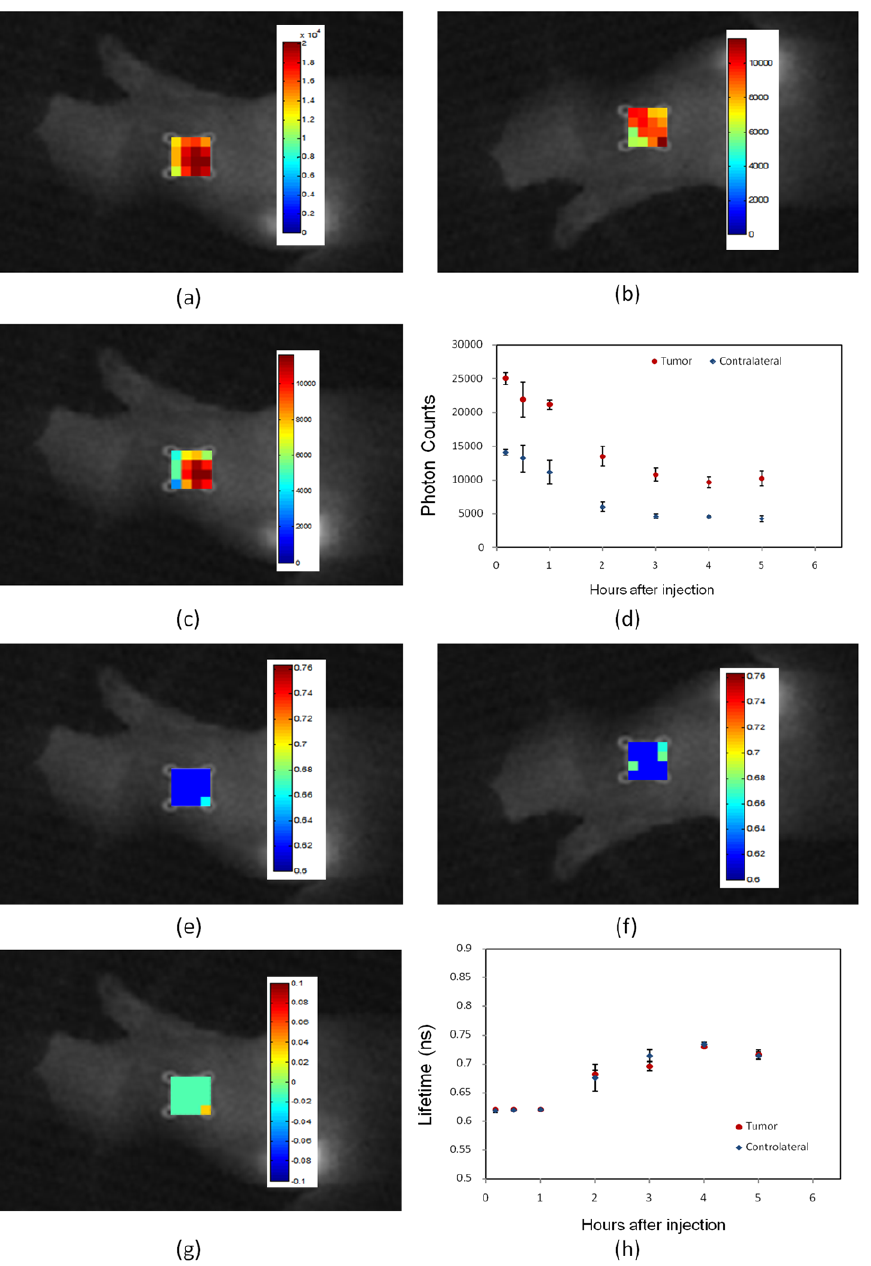
Figure 4. Invivo fluorescence imaging of xenograft mouse with high HER2 expressing human tumor model (BT-474) after injection of HER2-nonspecific Affibody H (His6-Z Taq :GS-Cys) conjugated to Dylight750. ( A ) Fluorescence intensity map at the tumor region. ( B ) Fluorescence intensity map at the contralateral site ( C ) The difference of fluorescence intensity at the tumor region and the contralateral site, mapped on the tumor region. ( D ) Pharmacokinetics of the fluorescence intensity at the tumor region and contralateral site after the injection over time. The data in Figs. ( D ) and ( H ) are the average data of three mice. Markers show the average and bars show the standard deviation. ( E rpar; Fluorescence lifetime map at the tumor region. ( F ) Fluorescence lifetime map at the contralateral site. ( G ) The difference of fluorescent lifetime at the tumor region and the contralateral site mapped on the tumor region. ( E ) Pharmacokinetics of the fluorescent lifetime at the tumor region and contralateral site after injection over time.